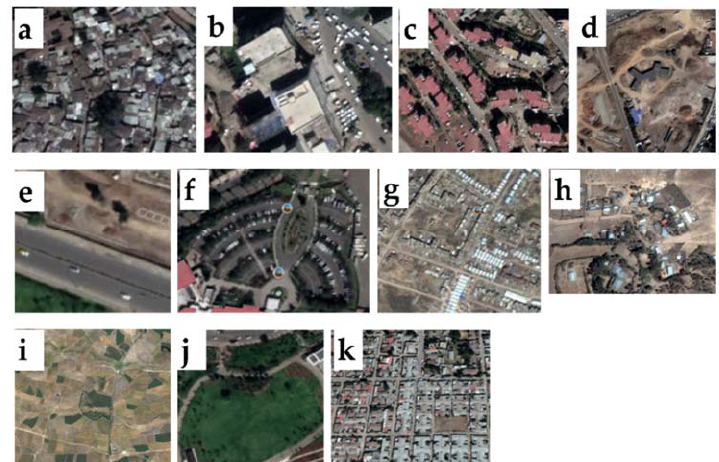
Figure 2. Land use classes identified for different neighborhoods. ( a ) Slums; ( b ) Commercial; ( c ) Condominiums; ( d ) Bare land; ( e ) Roads; ( f ) Parking lots; ( g ) Buildup foundations; ( h ) Traditional houses; ( i ) Farmland; ( j ) Green; ( k ) Low-rise houses; Table 1. The urban land use classification criteria.